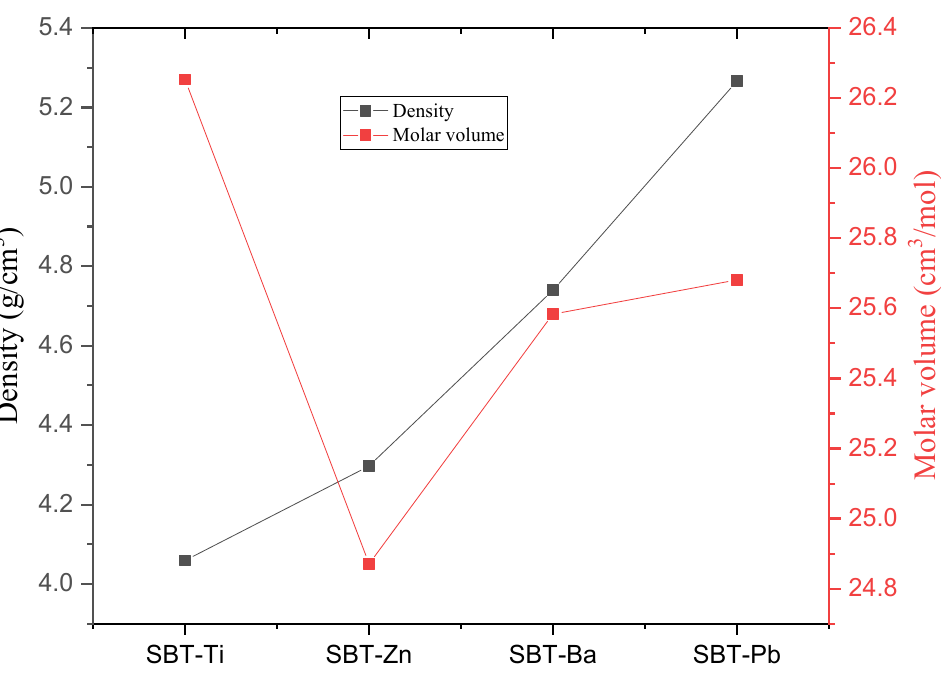
Figure 2. The correlation between density and molar volume of the fabricated SBT glasses.